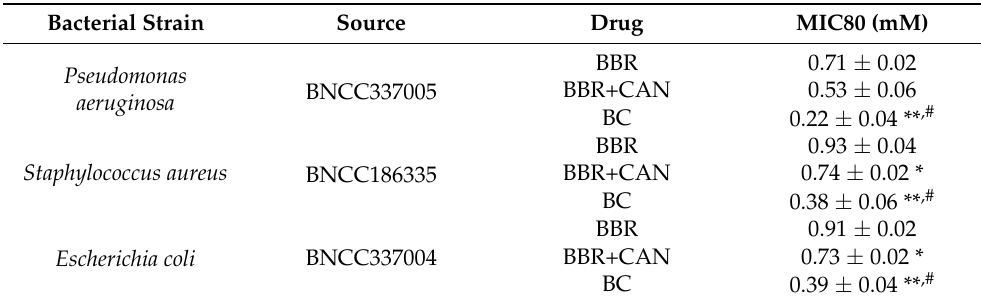
Table 1. Minimum inhibitory concentrations (MIC80) of BBR, BBR+CAN and BC against different strains. Bacterial Strain Source Drug MIC80 (mM)